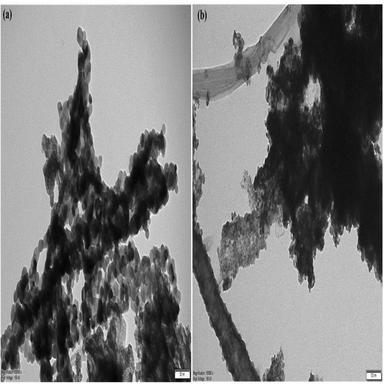
TEM analysis results with different scale sizes of 50 nm (a), 100 nm (b) for NiCeO2@f-MWCNT/EDA.